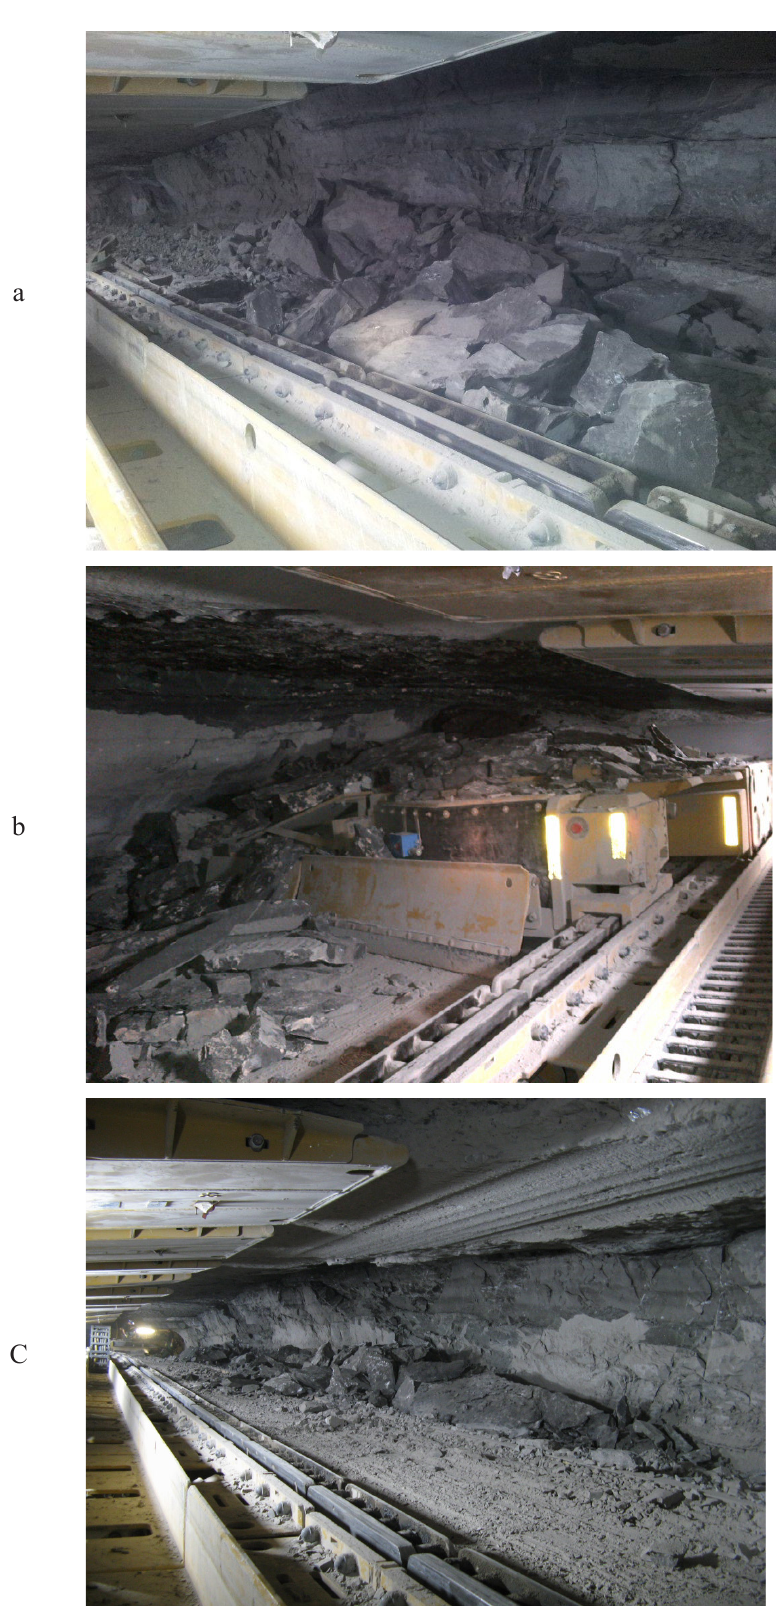
Figure 17: Examples of failures that occurred in the 5A/1 longwall: a, b) roof falls, c) wall